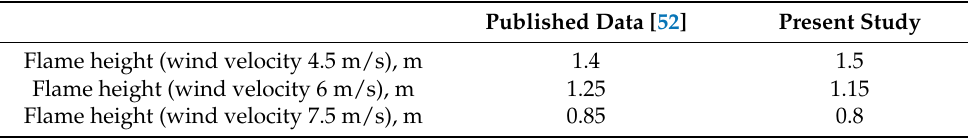
Figure 2. Comparison of the mean pressure coefficient for the experimental studies of [28,51], numerical simulation of [27], and three different grids number for the presented study. Table 1. Comparison of the flame height, as functions of the wind velocity, between published data [52] and the present study.